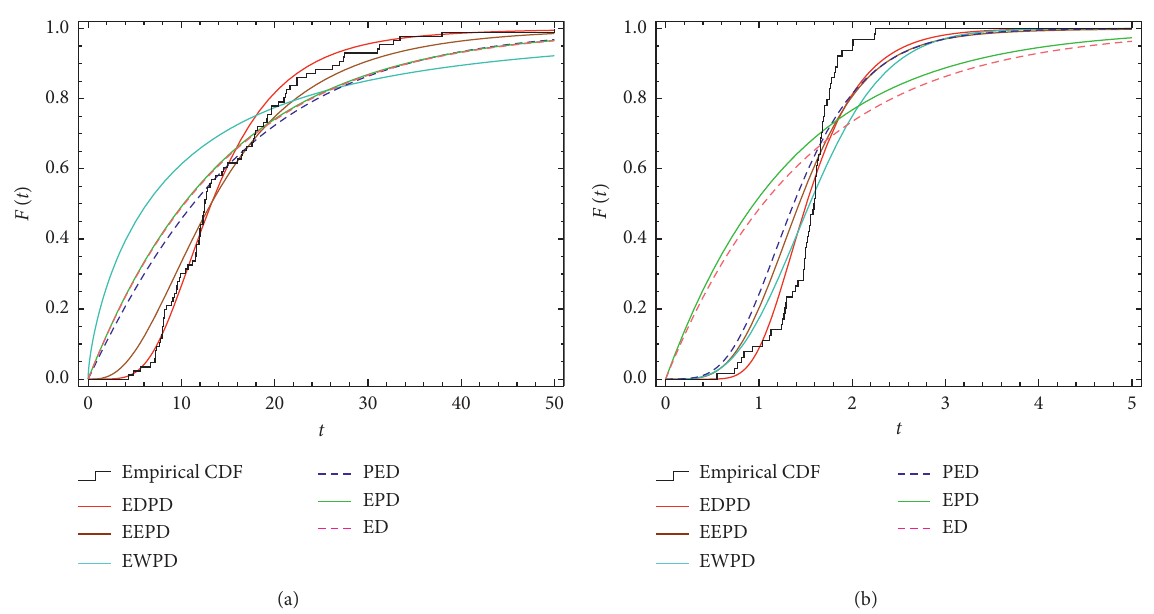
Figure 6: Empirical CDF versus CDF of EDPD, EWPD, EEPD, EPD, PED, and ED for the (a) first dataset and (b) second dataset. Table 3: Estimations using the ML, M, LS, and WLS methods for the parameters η , σ , and θ . The first censored sample The second censored